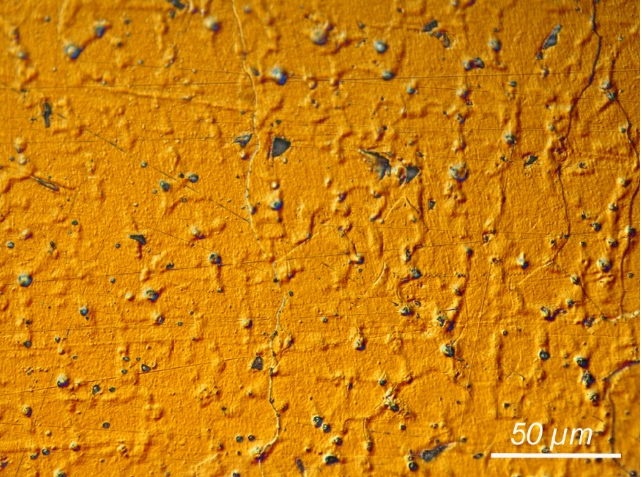
Figure 8. Metallographic structure in the middle part of weld metal.